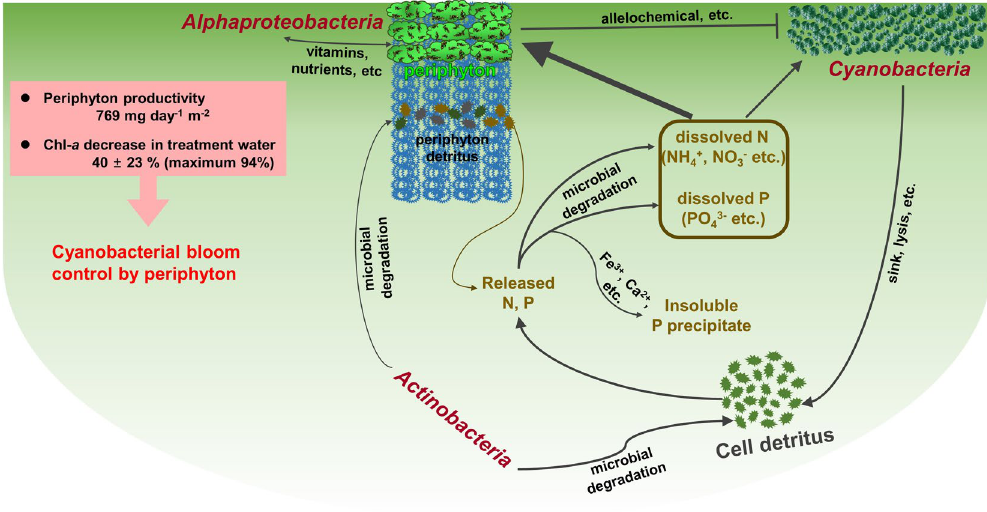
Figure 8. Periphyton effects on harmful cyanobacterial blooms and bacterial assemblages in mesocosms. Cyanobacteria detritus that sank to the bottom of the mesocosms will be degraded by Actinobacteria . This process will release organic N and P sources into the water. The released N will be further degraded by microbes (e.g., nitrifying bacteria) to several forms of inorganic nitrogen (NH 4 + , NO 3 − , etc.), resulting in increased TDN in the water. However, some of the released inorganic phosphate will bind to cations such as Fe 3 + and Ca 2 + and form insoluble precipitates. These dissolved N and P sources will be used by periphyton, bacteria and other organisms in the mesocosms. When periphyton grows, they would uptake a substantial amount of N and P, which otherwise could be primarily used for cyanobacterial growth. Periphyton prosperity will also harbor their beneficial microbes (e.g., Alphaproteobacteria ), to obtain essential resources (e.g., vitamins) with an exchange of photosynthates (e.g., carbon sources). Periphyton and their symbiotic microbes decreased Chl- a concentrations up to 94% in the treatment water compared to the control